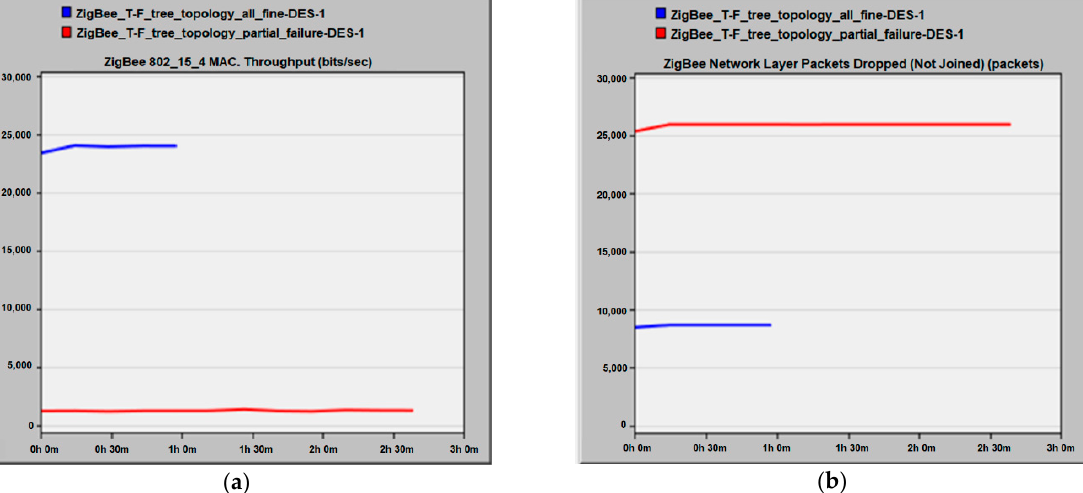
Table 6. The statistics of the network operation in scenarios I and